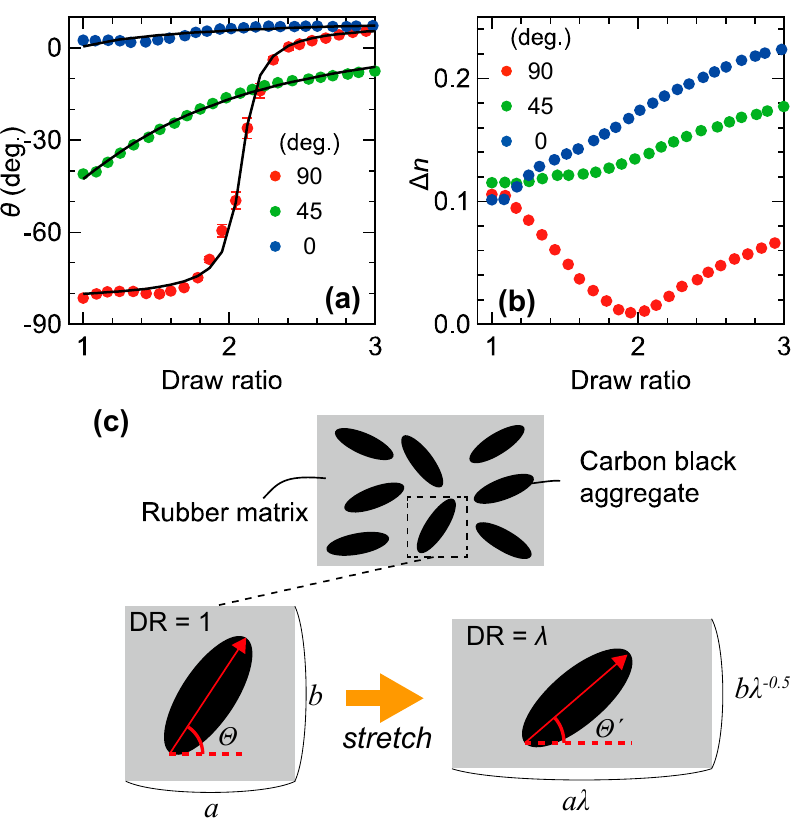
Figure 5. Draw ratio dependence of ( a ) the angle of the slow optic axis and ( b ) the degree of the birefringence of three FKM samples with initial orientation angles of 0 ◦ (blue circles), 45 ◦ (green circles) and 90 ◦ (red circles); ( c ) Schematic of our model for the change in the orientation of the CB aggregates due to mechanical stretching. Here, λ is defined as the draw ratio. Part of this figure is reproduced from M. Okano et al. Sci. Rep. 6 , 39079 (2016) [25]. Licensed under CC BY 4.0.